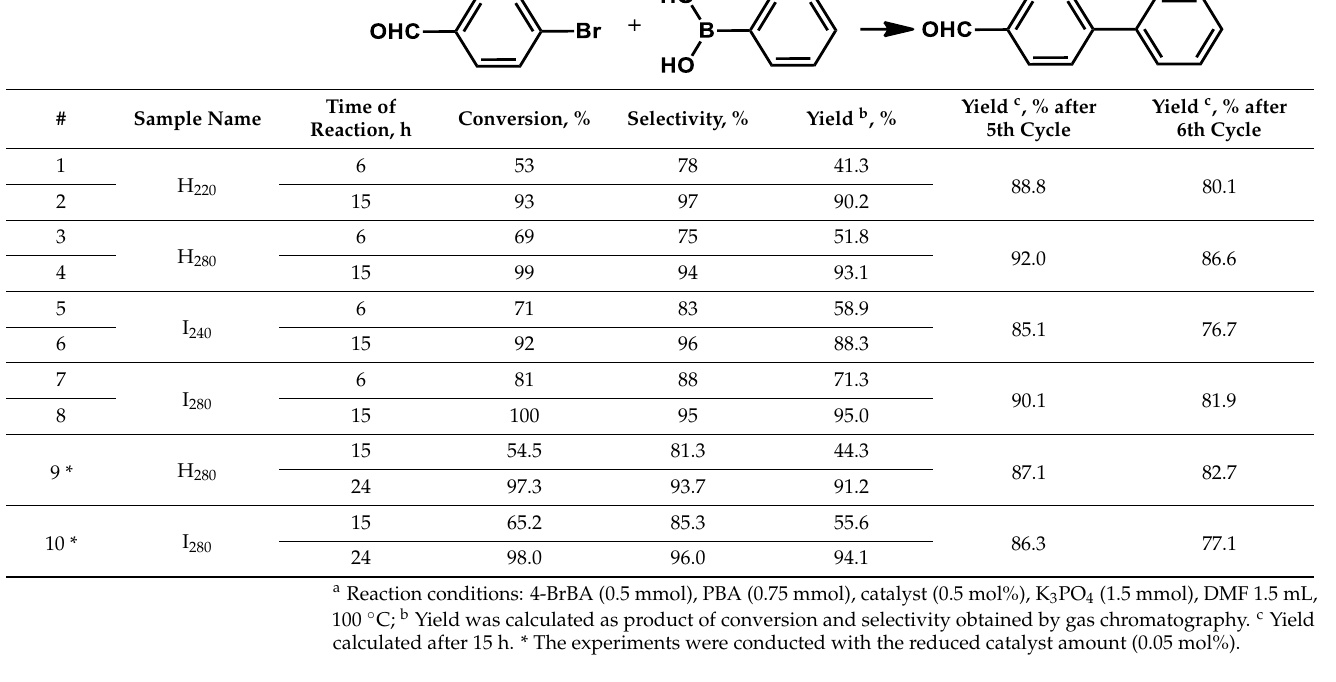
Table 1. Results of the catalytic performance of Ni NPs@PPP in the Suzuki–Miyaura reaction a .